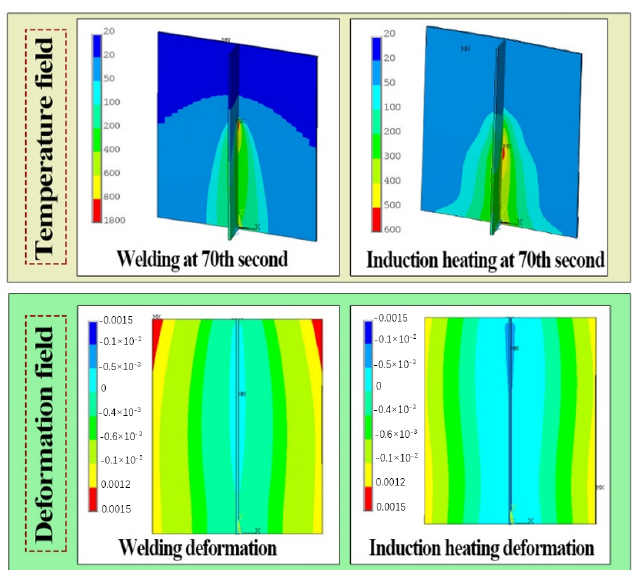
Figure 11. Temperature and deformation distribution obtained by the moving mesh method (5 mm).